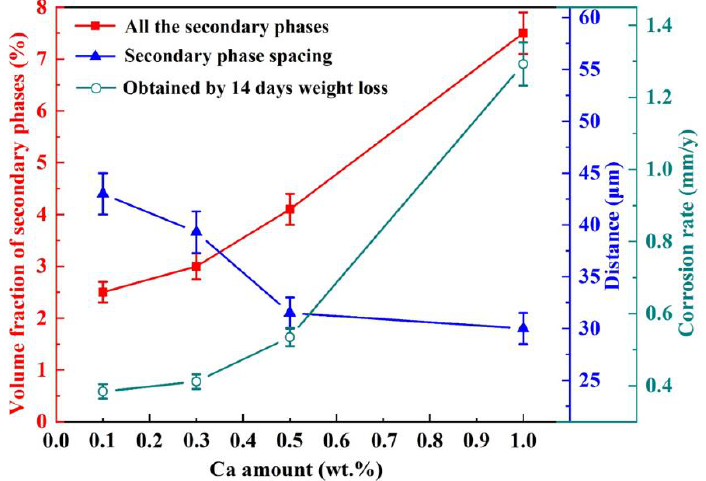
Figure 9. Relationship between corrosion rate, secondary phase spacing and volume fraction of the ZM-xCa alloys.